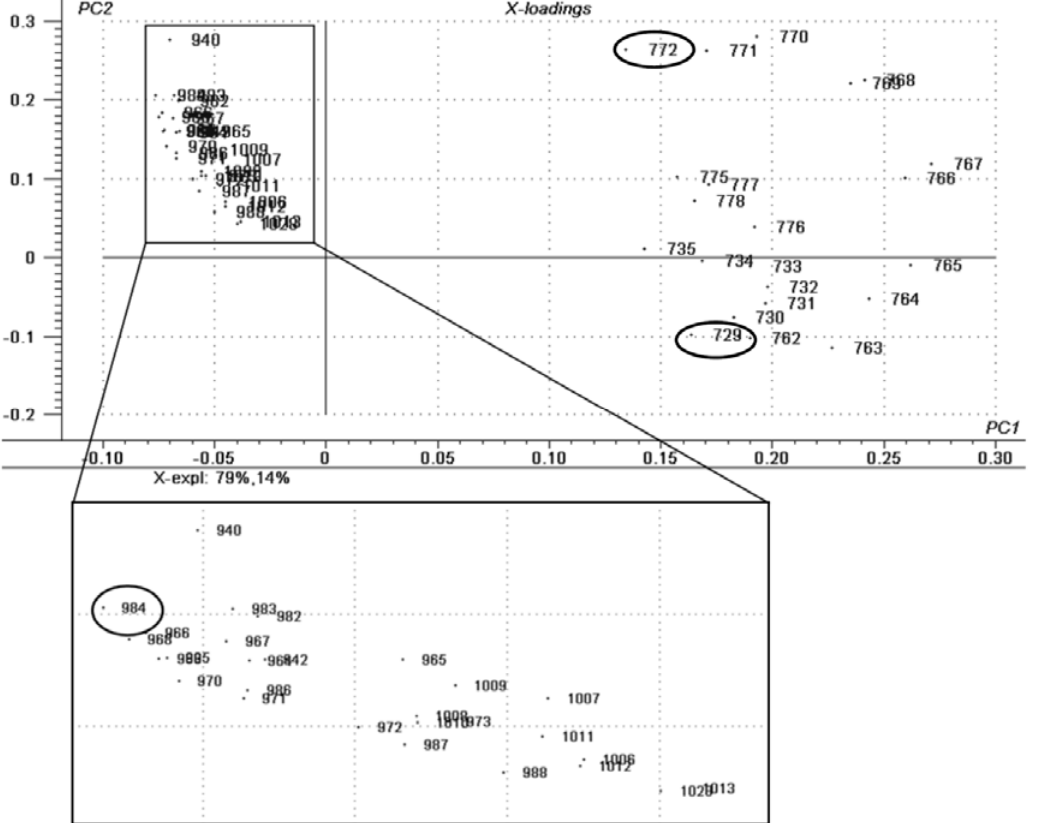
Figure 4. Correlation loadings for the principal components of the eyeliner samples: It is noted there is a very good correlation for both the new and “in-use” groups, as they presented ions in the m/z range of 700–800 (lower TAGs). It is possible to observe several ions on the m/z 900 and higher. The marked ions were the ones chosen as biomarkers for each degradation